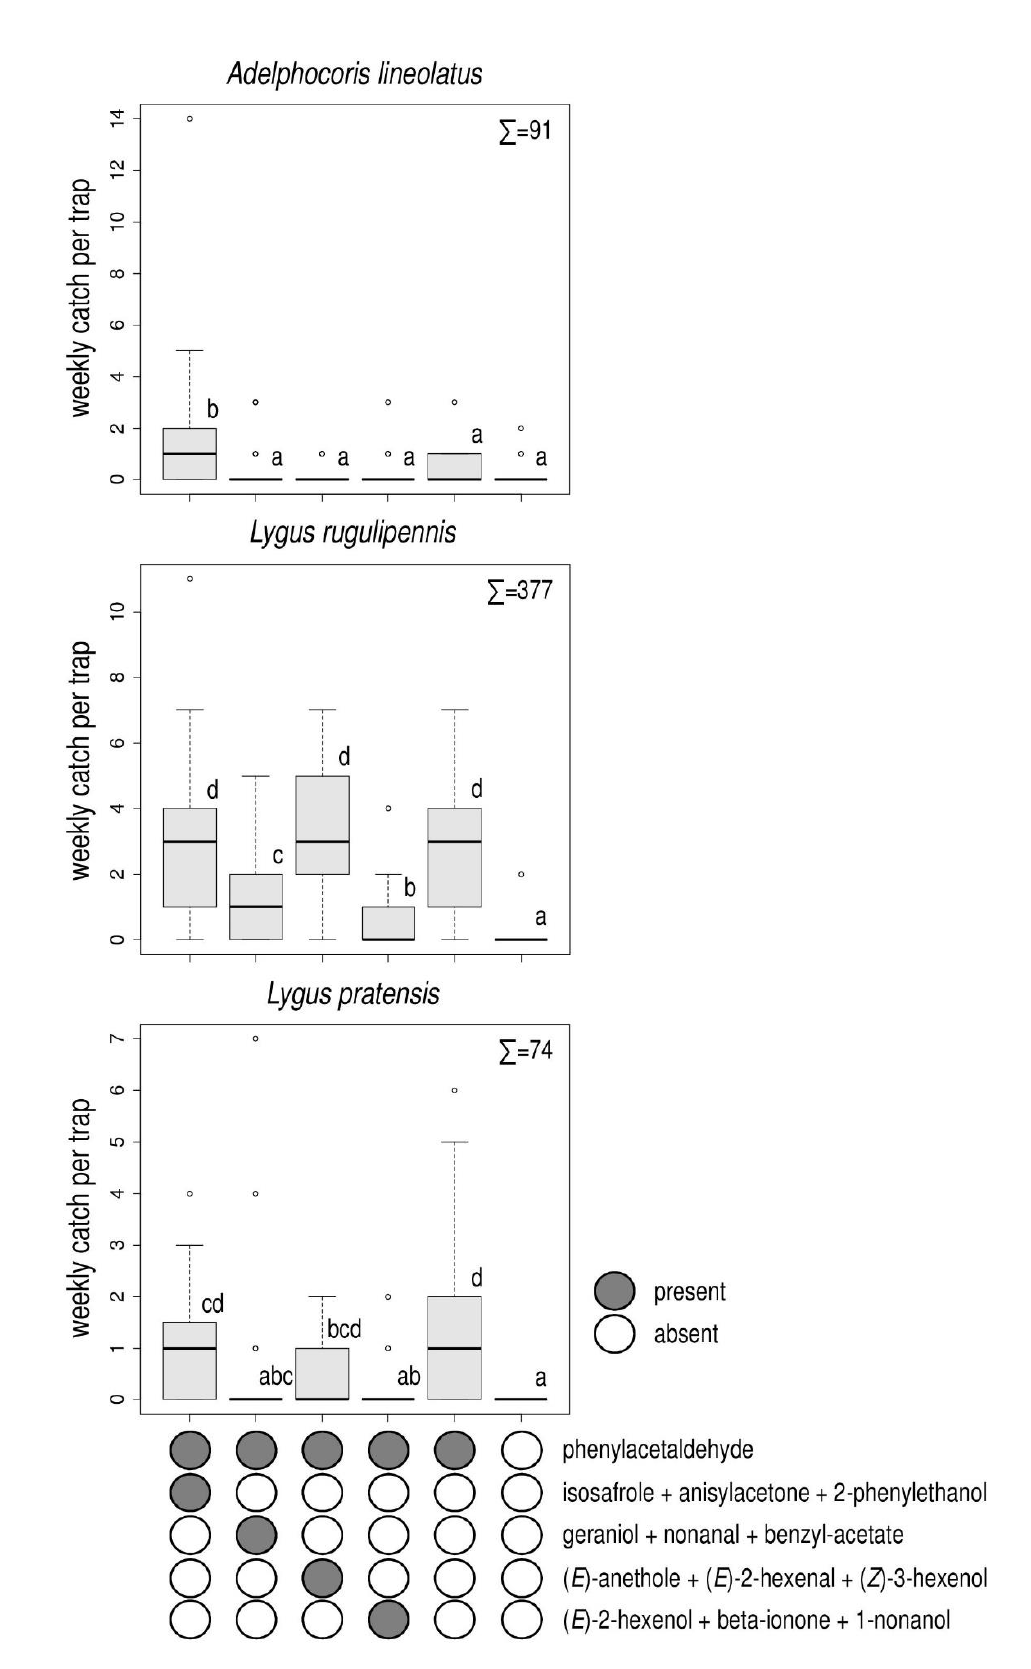
Figure 1. Weekly catches of Adelphocoris lineolatus , Lygus rugulipennis and L. pratensis in phenylacetaldehyde baited traps alone, in combination with ternary blends and in unbaited traps (Experiment 1). (Significance: Kruskal-Wallis test, pairwise comparisons by Wilcoxon test with Bonferroni correction at p=0.05). ’∑’ indicates the total number of individuals caught of the respective species in the